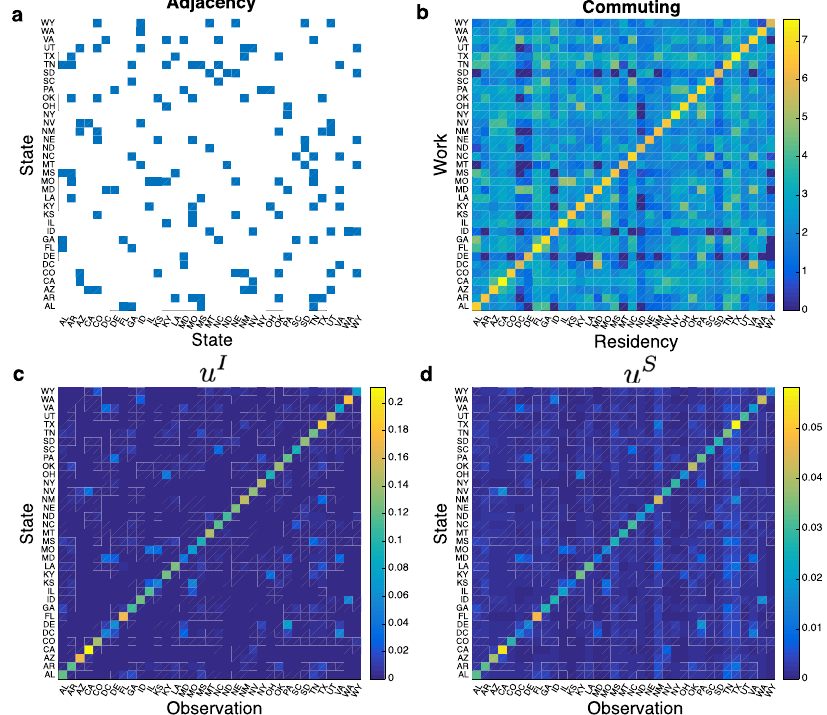
Fig. 2 Connectivity and uncertainty reduction across 35 US states. a The adjacency matrix for 35 US states. Adjacent states are highlighted by blue squares. b Numbers of commuters among 35 US states from the 2010 census survey. Color shows the logarithmic-transformed (base 10) commuting population from resident ( x -axis) to work ( y -axis) locations. Surveillance data from one state (x-axis) can reduce the uncertainty of infected ( c ) and susceptible ( d ) populations in other states ( y -axis). Color indicates the reduced fraction of variance for infected and susceptible populations ( u I and u S ). Results are averaged over data assimilation during nine seasons.